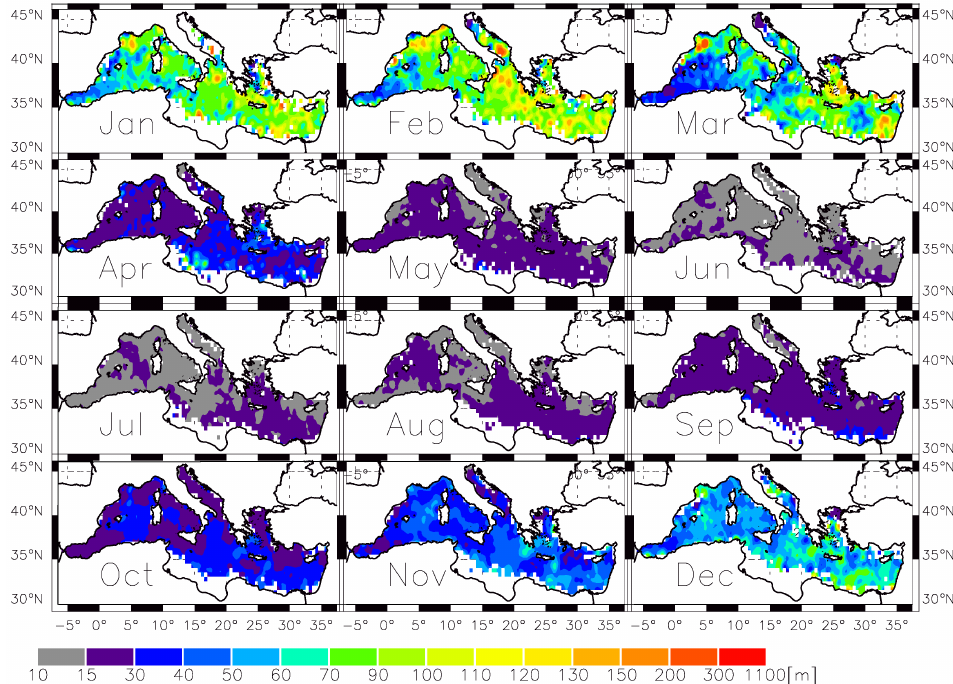
Fig. 3. Climatology of Mixed Layer Depth. Reproduced from D’Ortenzio et al. (2003) by permission of American Geophysical Union.